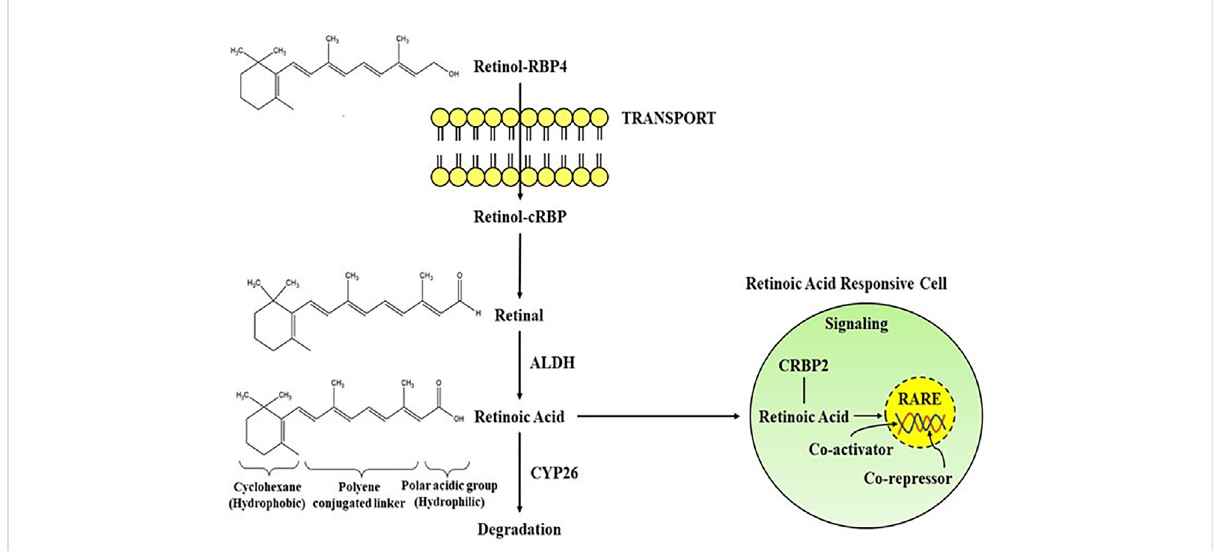
FIGURE 1 Schematicrepresentation ofthetransportand signaling pathways of retinoicacid from retinol via the activityof alcohol dehydrogenase (ALDH) and degradation through CYP26. Retinoic acid mediates its activity by interacting with the RA receptors in RA responsive cell. RBP, Retinol binding protein; RARE, Retinoic acid response